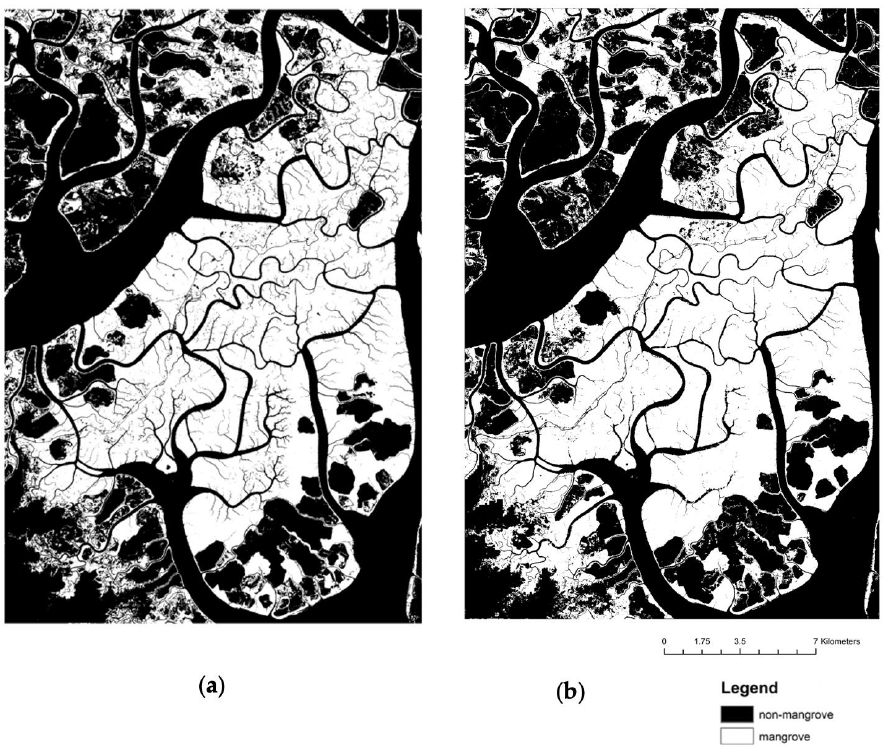
Figure 14. Mangrove distribution maps of Wunbaik Mangrove Forest in ( a ) 2020 and ( b ) 2015 predicted by the proposed ANN method.